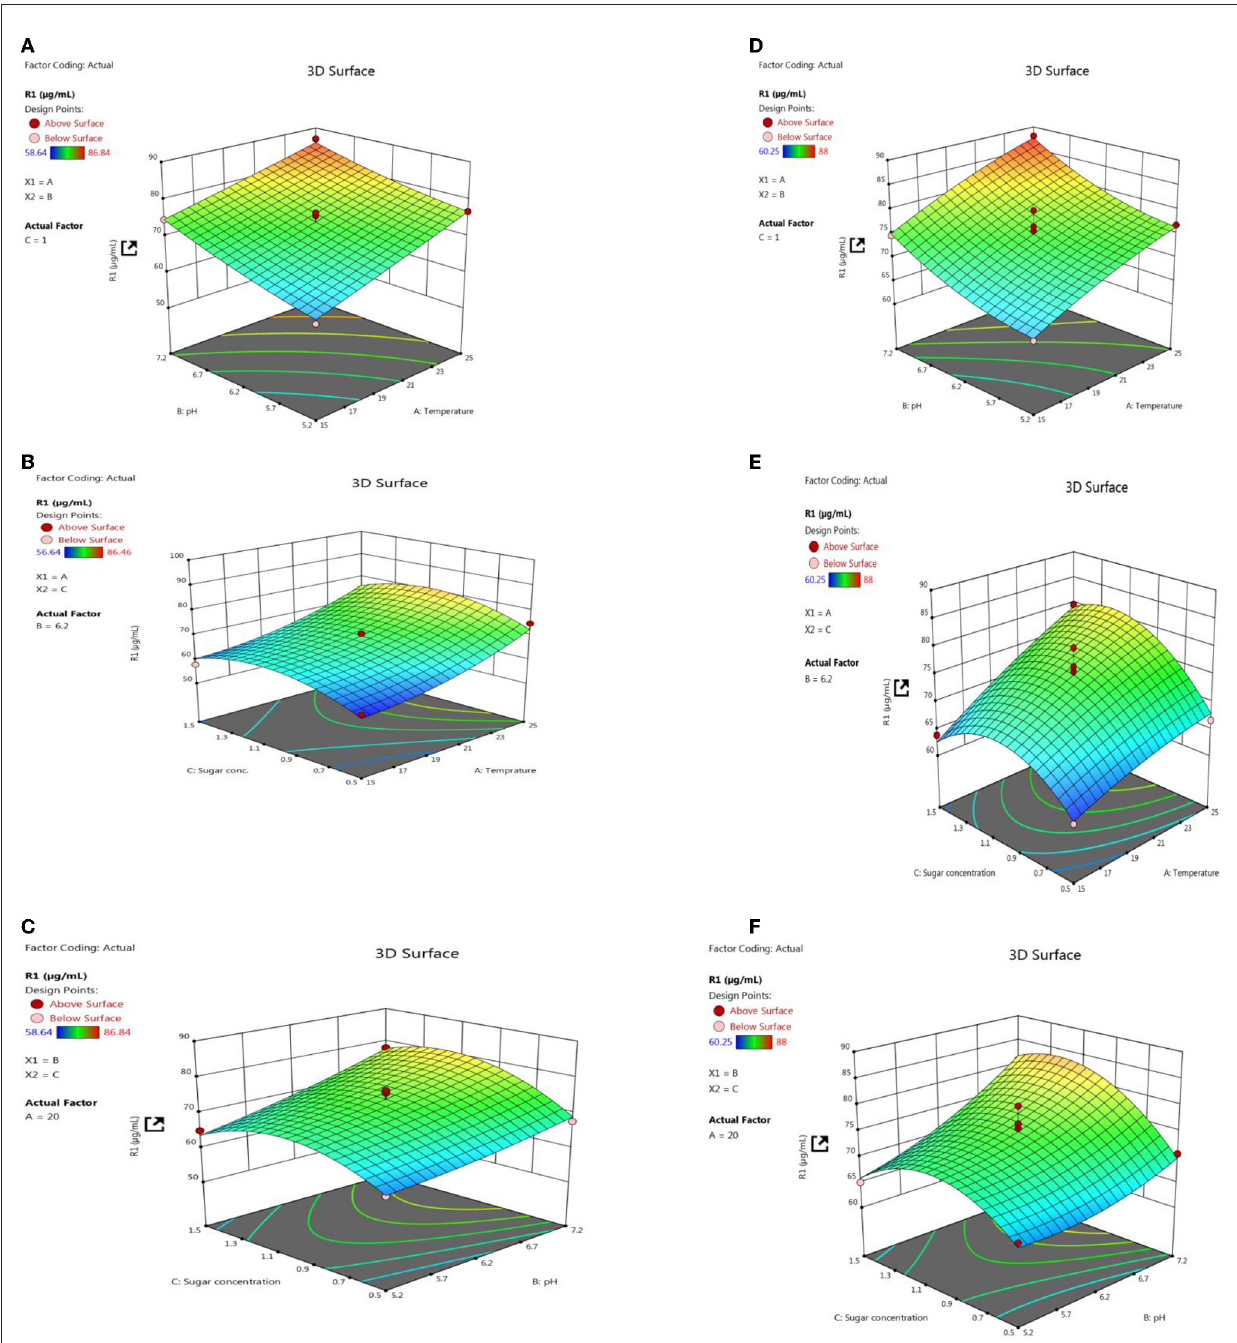
FIGURE12 RSM plots for optimizing P quantification of L3 (A–C) and P2 (D–F) PSB treatment including the interaction of three variables, e.g., temperature, pH, and sugar concentration.